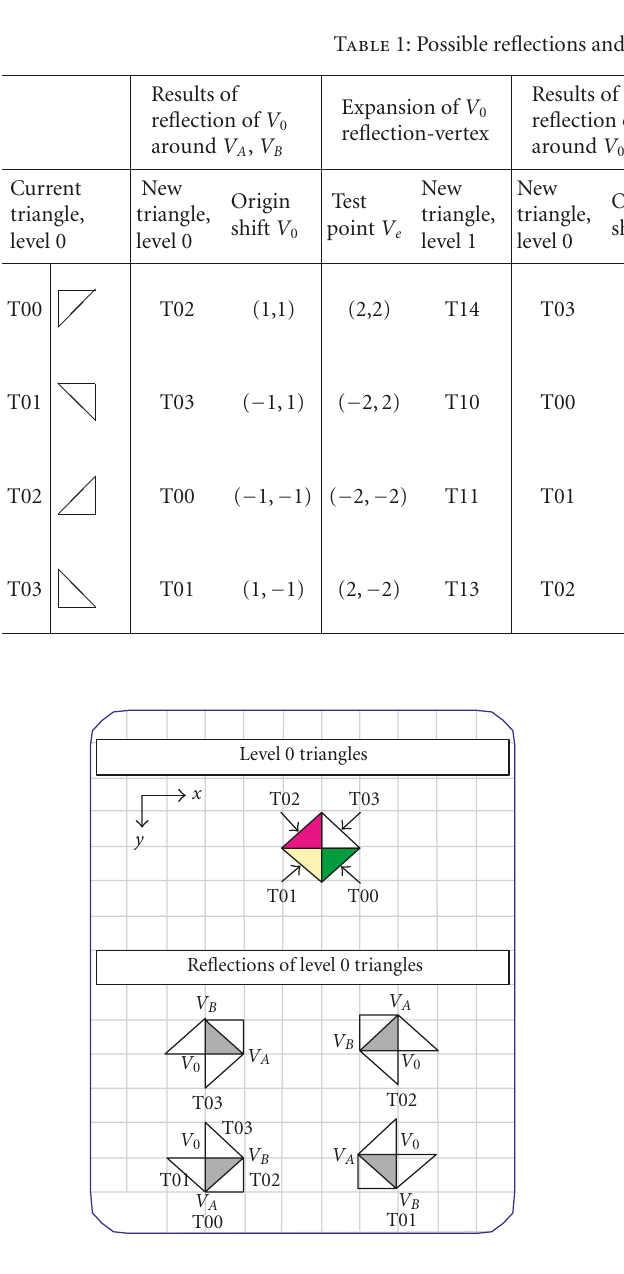
Figure 2: Possible reflections for level 0 triangles. The original tri- angle is the dark one.